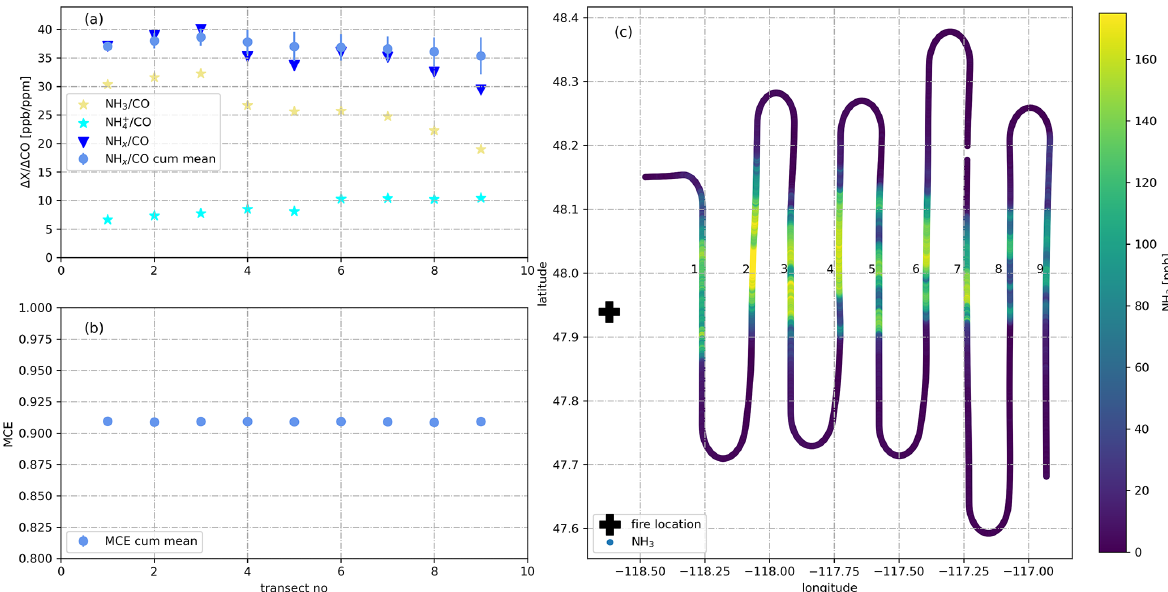
+ /CO, NH x /CO and cumulative mean NH x /CO as measured during nine downwind transects of the plume emitted Figure 3. (a) NH 3 /CO, NH 4 from the Williams Flats Fire on 7 August 2019. NH 3 /CO increases during the first three transects which were thus used for determining EF NH and EF NH . (b) Mean MCE as measured for the same nine downwind transects. MCE remains stable at ∼ 0 . 91 indicating stable x 3 burning conditions. (c) Latitude–longitude plot showing the location of the fire (black cross) and the color-coded flight track in the NH 3 mixing ratio.